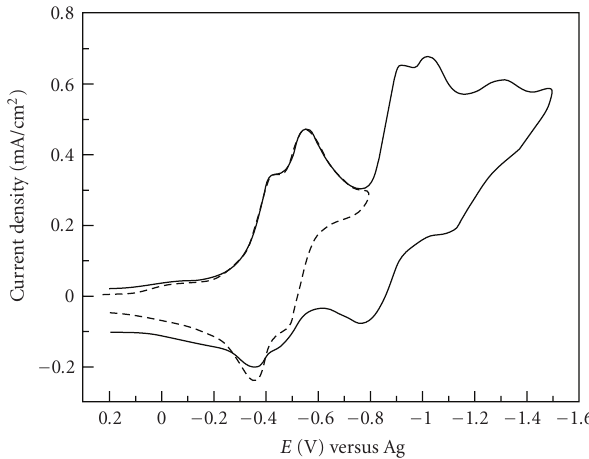
Figure 2: CVs for reduction of 1mM CQ at a GC electrode in rigorously dried CH 3 CN containing 0.10 M TBAPF 6 as a supporting electrolyte. The scan rate was 100mV/s.